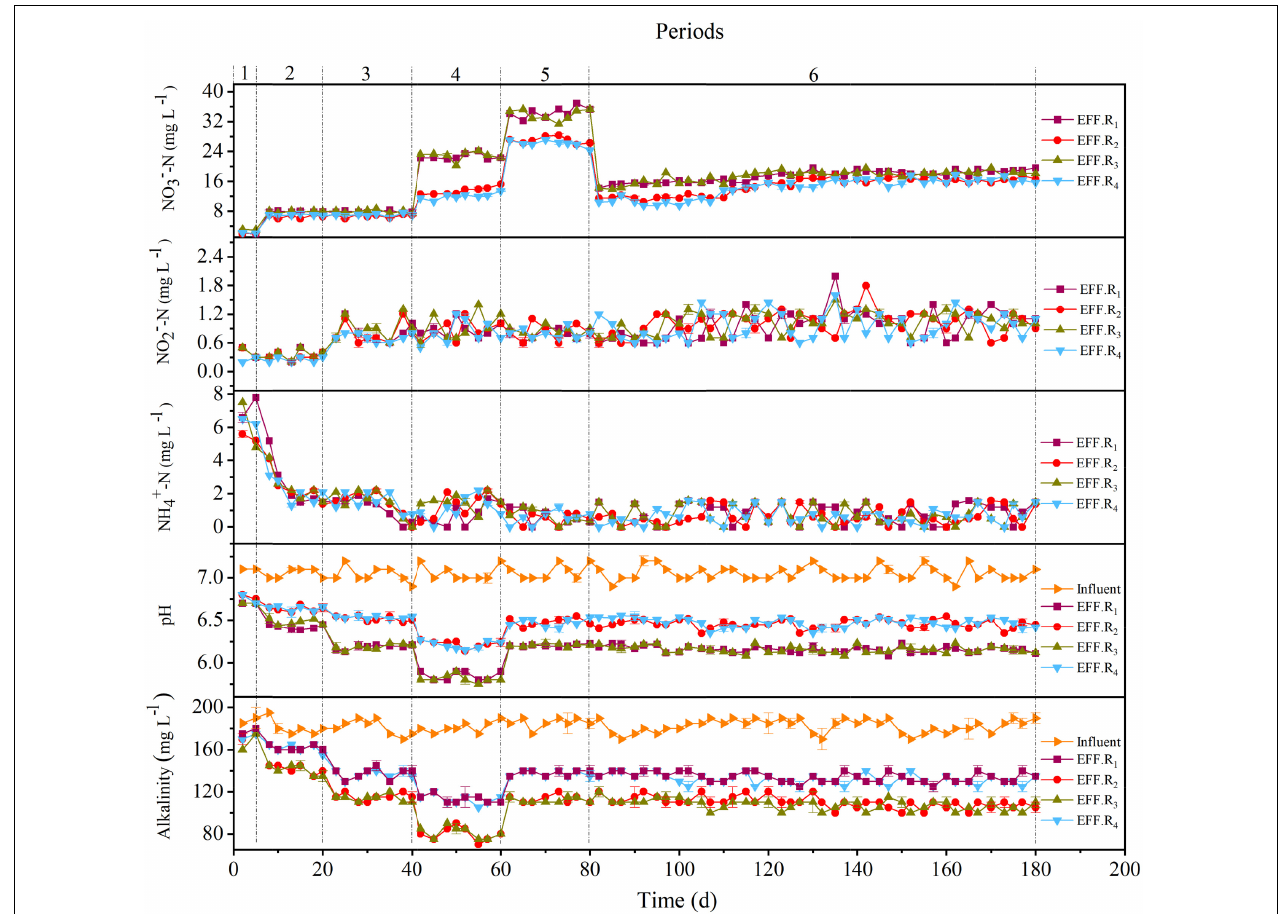
FIGURE 1 | Performances of the R 1 –R 4 reactors during periods